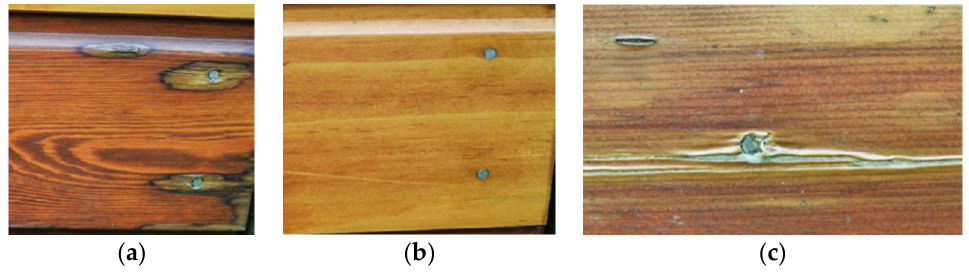
Figure 12. ( a ) Control larch, ( b ) acetylated pine, and ( c ) western red cedar after 7 years of outdoor testing.